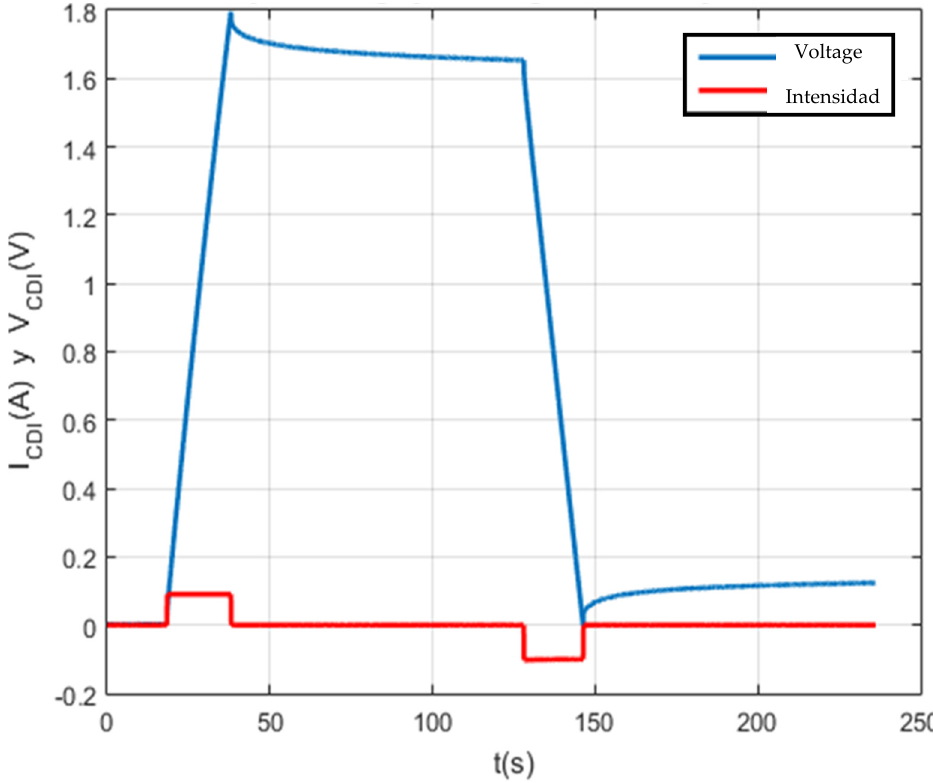
Figure 18. Charge and discharge test at Vcmax = 1.8 V and Icon = 0.1 A.